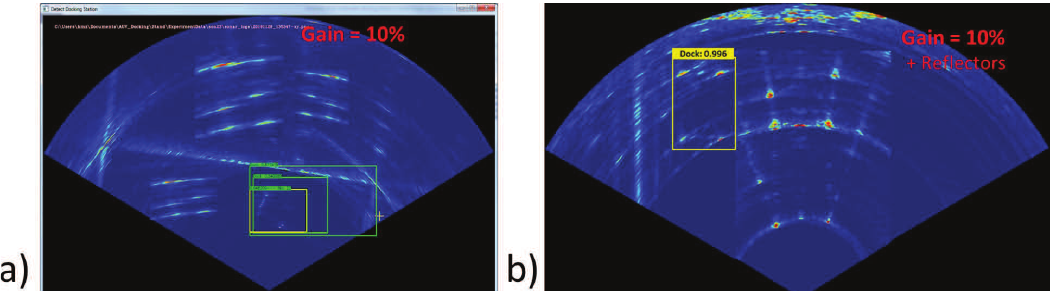
Figure 14. Example results Test 2: Robustness by ( a ) increased gain and ( b ) extra noise caused by nearby reflectors.